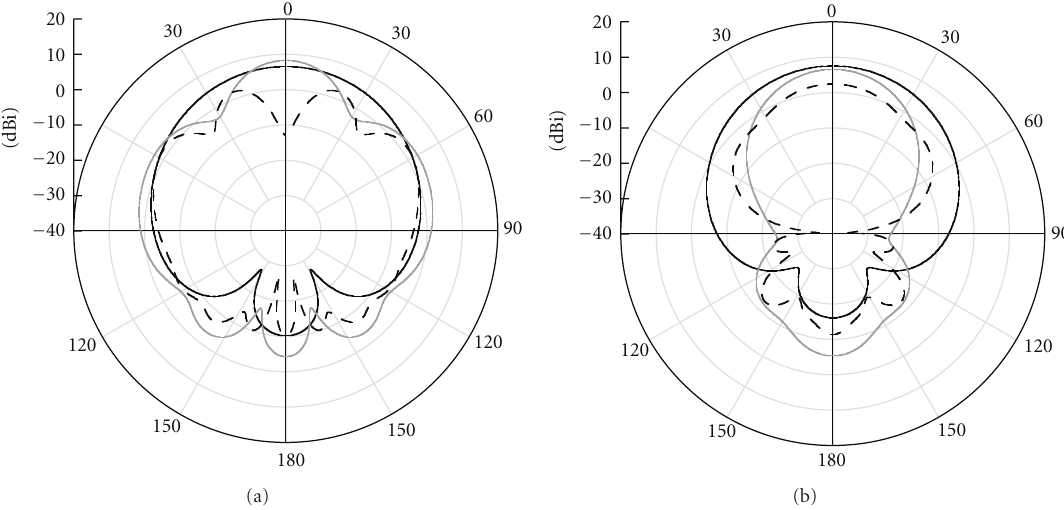
Figure 6: Antenna in Figure 2. Gain in polar form on the principal elevation plane φ = 0 ◦ of the single element at di ff erent frequencies in the operational bandwidth 5–25 GHz: 5GHz ( solid black line ), 10 GHz ( gray line ), 20GHz ( dashed black line ). (a) Ports 1 and 2 feed the upper element, exciting a field along the θ direction. (b) Ports 3 and 4 feed the lower element, exciting a field along the ϕ direction.